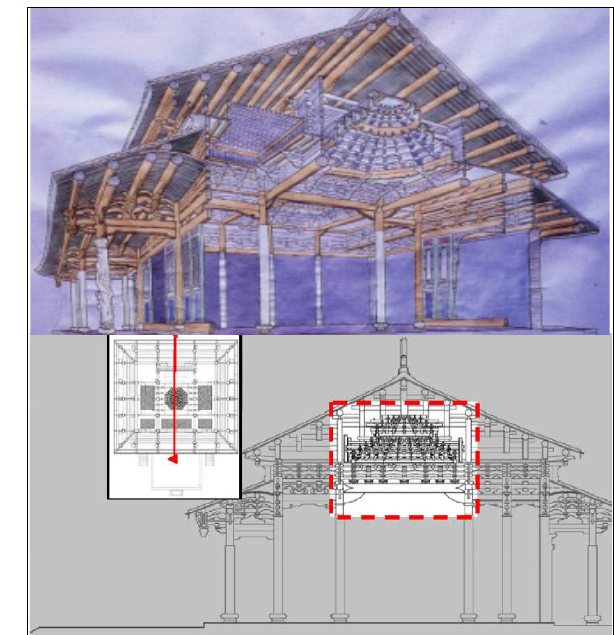
Fig 2. Main Hall of the Taipei